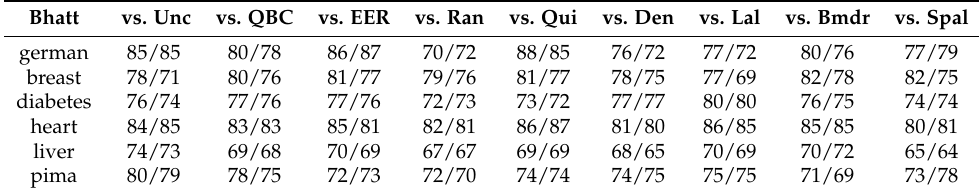
Figure 1. The comparison of different performance on different datasets, and it can be seen that the active learning algorithm with Bhattacharyya distance as the measurement still maintains a high learning accuracy, and shows a high-speed upward trend as the number of query samples increases. Table 3. Algorithm confrontation